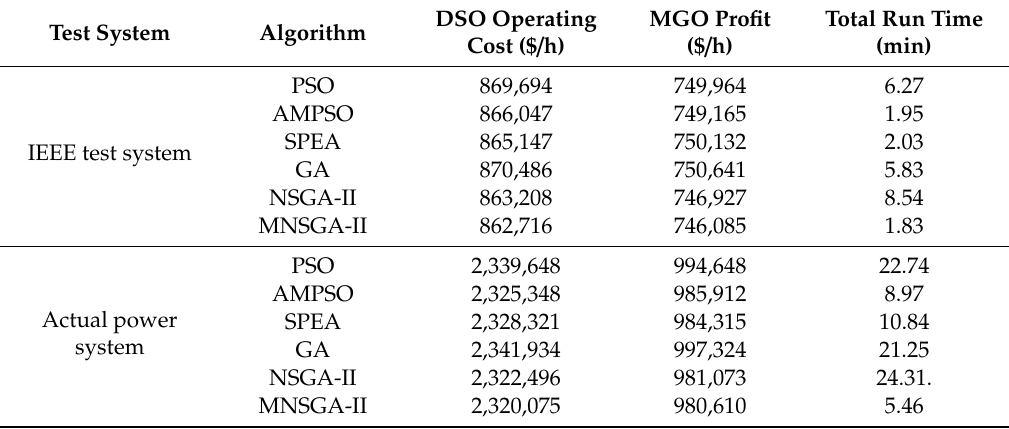
Figure 12. Optimization results for each system. PSO: particle swarm optimization; adaptive modified PSO; SPEA: strength Pareto evolutionary algorithm; GA: strength Pareto evolutionary algorithm; NSGA-II: non-dominated sorting genetic algorithm II; MNSGA-II: modified version of the non-dominated sorting genetic algorithm II: ( a ) IEEE test system, ( b ) Actual power system. Table 11. Comparison result of different algorithms for Case 2.